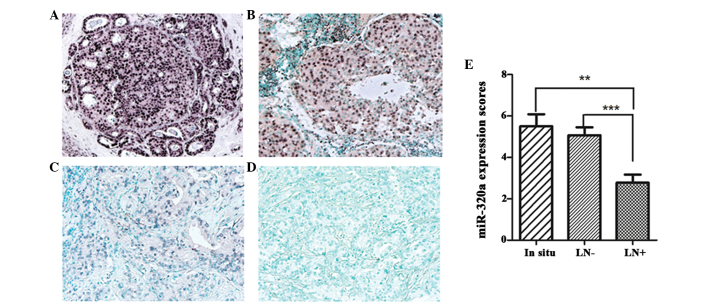
miR-320a is underexpressed in invasive breast cancer tissues. Representative images (magnification, ×200) of chromogenic in situ hybridization for miR-320a in (A) in situ breast carcinoma, (B) invasive breast cancer without lymph node metastasis and (C) invasive breast cancer with lymph node metastasis. (D) Scramble RNA was used as a negative control. (E) miR-320a expression scores were compared between invasive breast cancer tissues and in situ breast carcinoma tissues (P<0.01). **P<0.01, in situ vs. LN+; and ***P<0.001, LN+ vs. LN−. In situ, in situ breast carcinoma; LN−, invasive breast cancer tissues without lymph node metastasis; LN+, invasive breast cancer tissues with lymph node metastasis. miR-320a, microRNA-320a.